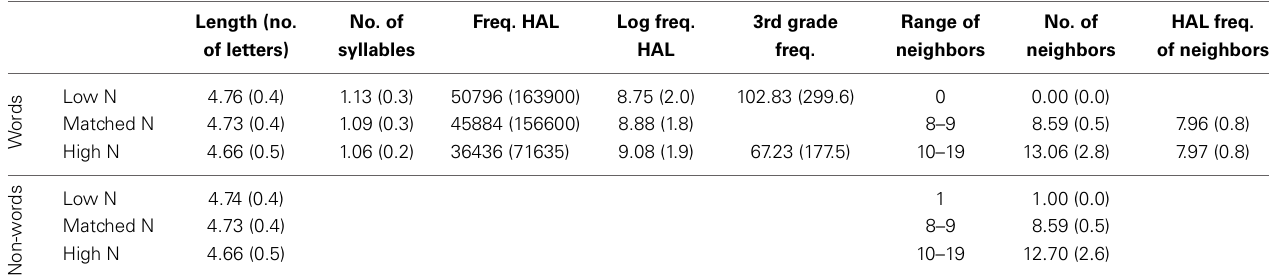
Table 2 | Lexical properties of target